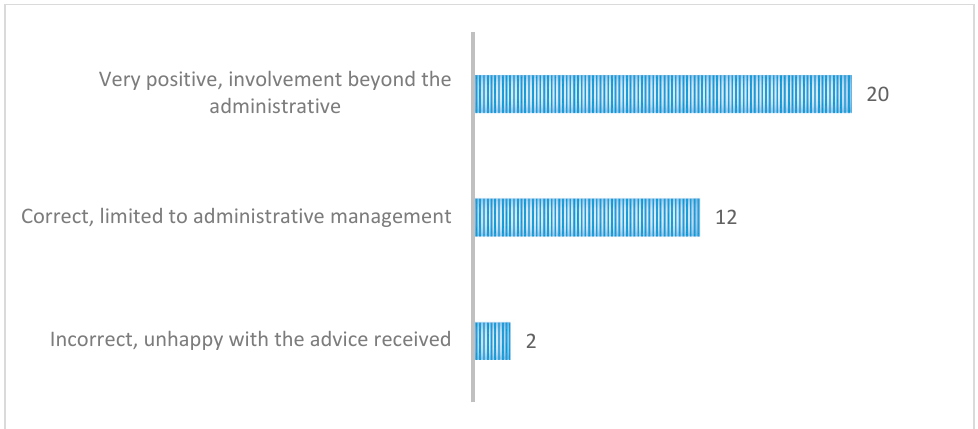
Figure 3. What has CEDER's role been in implementing your project? Source: Own elaboration .